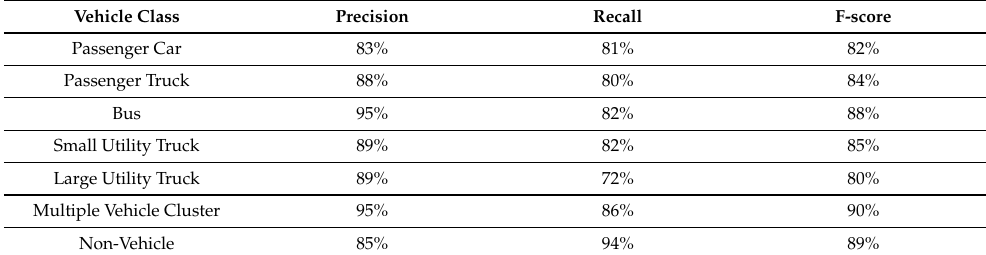
Table 19. Different evaluation metrics for the detected classes within Video 4.